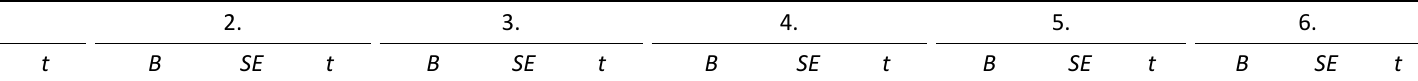
Table 2. Differences in the number of likes between